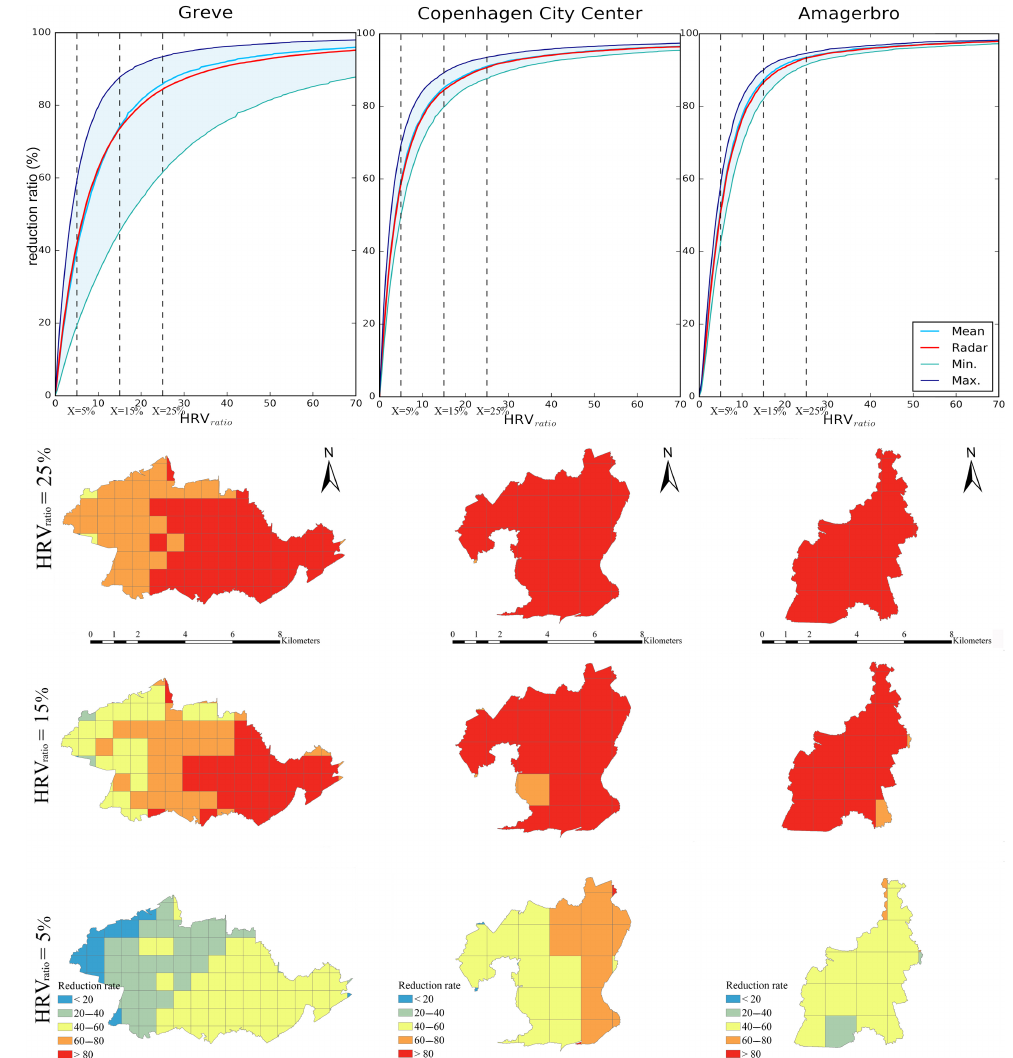
Figure 4. Spatially varying reductions of HRV ratio computed based on the radar rainfalls of the three case areas. The curves present the deviation of the screening processes due to the impact of rainfall heterogeneity. The maps demonstrate how the reductions vary spatially for the three HRV ratio of 5%, 15% and